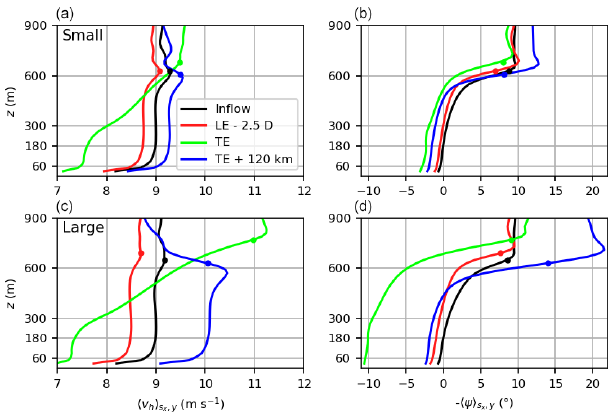
Figure 8. Vertical profiles of the horizontal wind speed (a, c) and the wind direction (b, d) for the small wind farm (a, b) and the large wind farm (c, d) . The profiles are averaged in time, along y and over one turbine spacing along x . Horizontal lines are shown at z = 60m (rotor bottom), z = 180m (hub height), z = 300m (rotor top) and z = z i = 600m (BL height at the inflow). Dots mark the BL height at the respective x